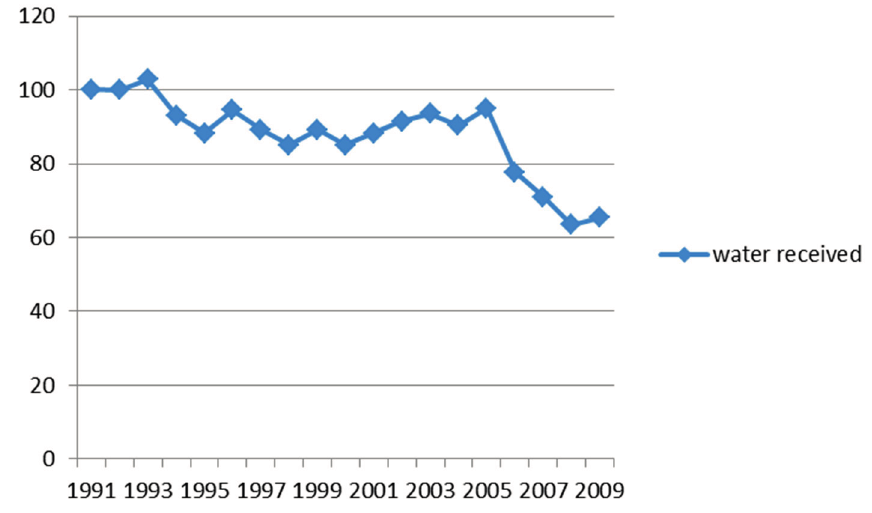
Figure 4. Total water received and utilized in Ferghana Province from 1991 to 2009 (deviation from 1991), (Source: compiled from data of the irrigation department of Ferghana